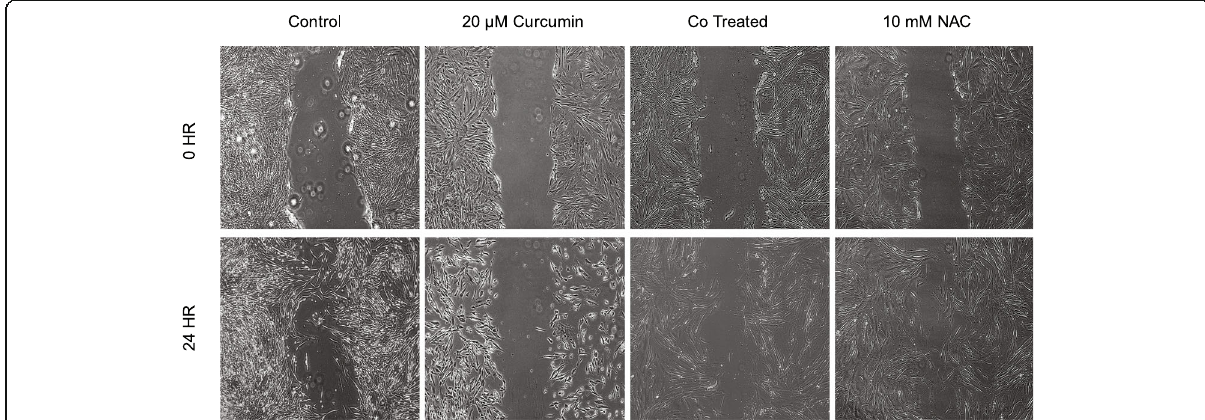
Fig. 3 Representative scratch test results in IPF-F after 24-h treatment with NAC and curcumin: 20 μ M curcumin reduces wound closure in IPF-F as compared to untreated control. 10 mM NAC does not have a significant effect on wound closure rate. Combination treatment with 40 μ M curcumin and 10 mM NAC results in decreased wound closure as compared to untreated control but is attenuated in comparison to 20 μ M curcumin alone. Morphological changes observed in the curcumin treatment are also attenuated in the combination treatment